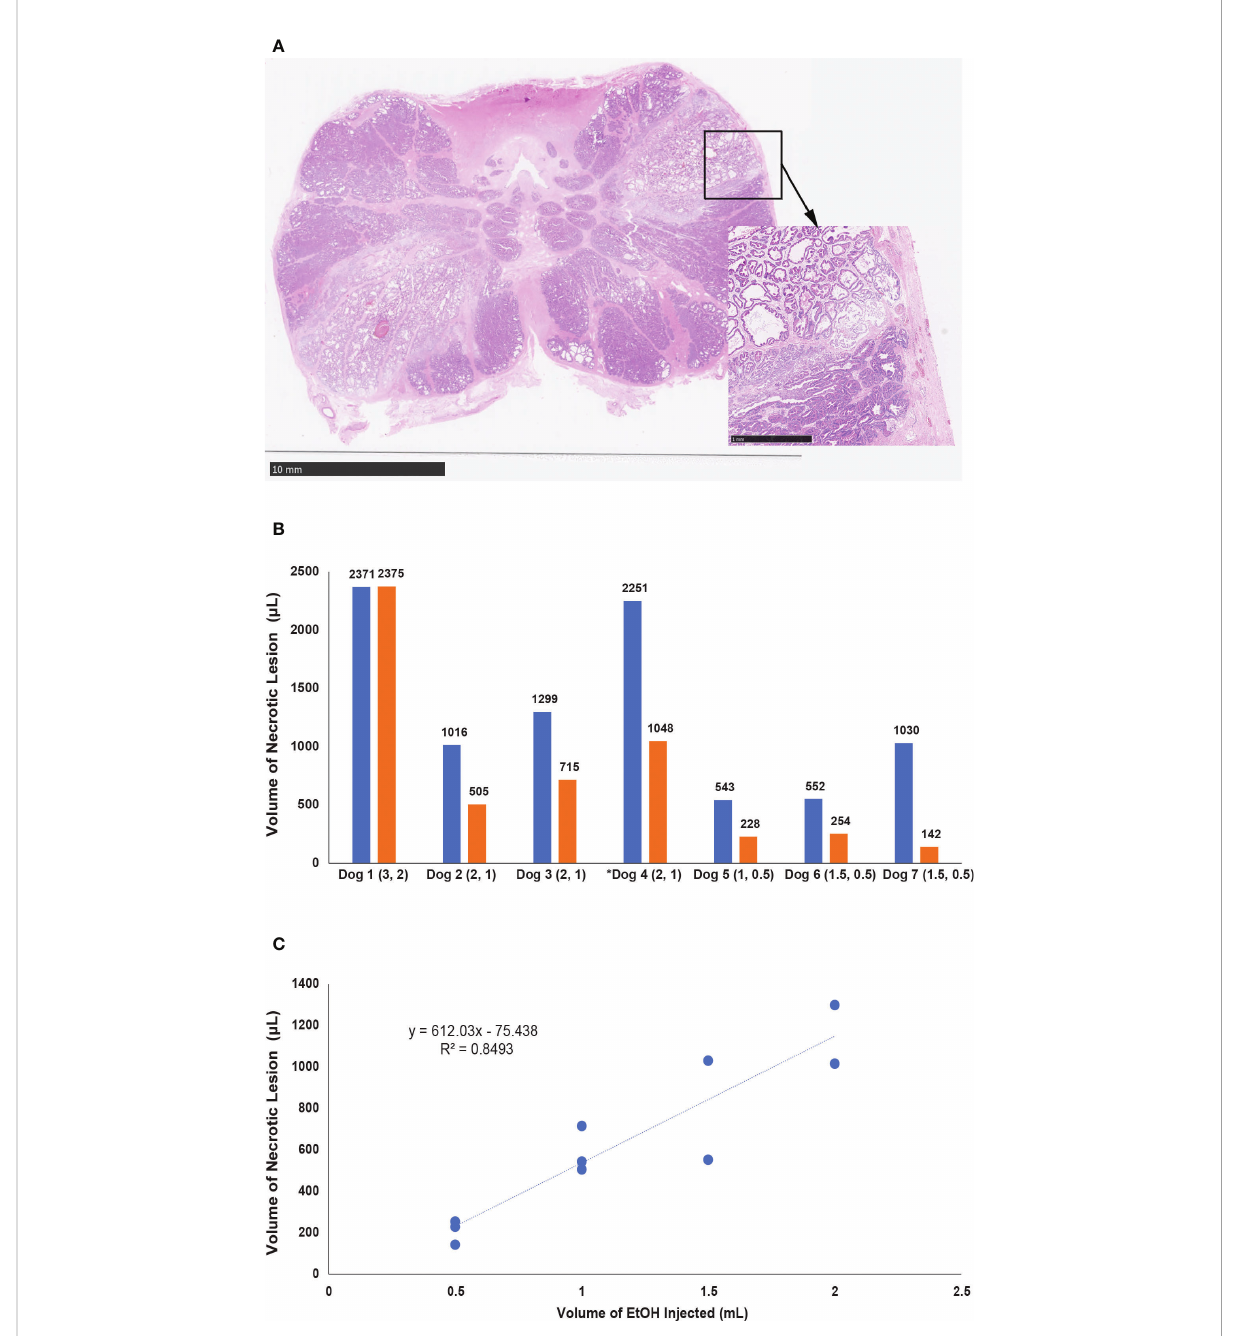
FIGURE 3 (A) Section of the canine prostate two hours after EtOH injection, oriented parallel to the prostate base. High-power magni fi cation (marked by arrow) depicting intact fi bromuscular pseudocapsule adjacent to the necrotic lesion. (B) Graph summarizing the volume of tissues lesions in 7 canine prostates 2 hours post injection. The volume injected (mL) is listed in brackets under x axis, number above each bar represents the volume of the lesion. Dog 1 was used in a dose fi nding experiment and the Dog 4 (marked with asterisk) represents injection with a 2 cm-long porous needle. (C) Plot demonstrating the correlation of the volume of ethanol and the volume of necrotic lesion in all experiments where needle with 1 cm long porous segment was used for